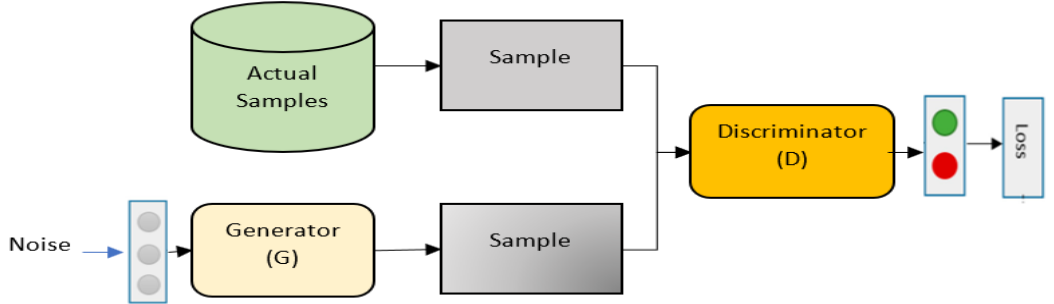
Figure 6. An illustration of the GAN.